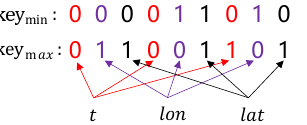
Figure 14. Example of key range in